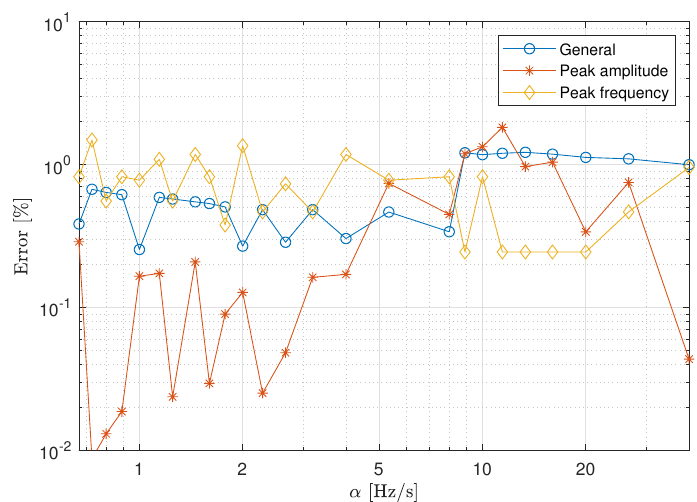
Figure 6. Estimated errors in the experimental transmissibility for the elastomeric material